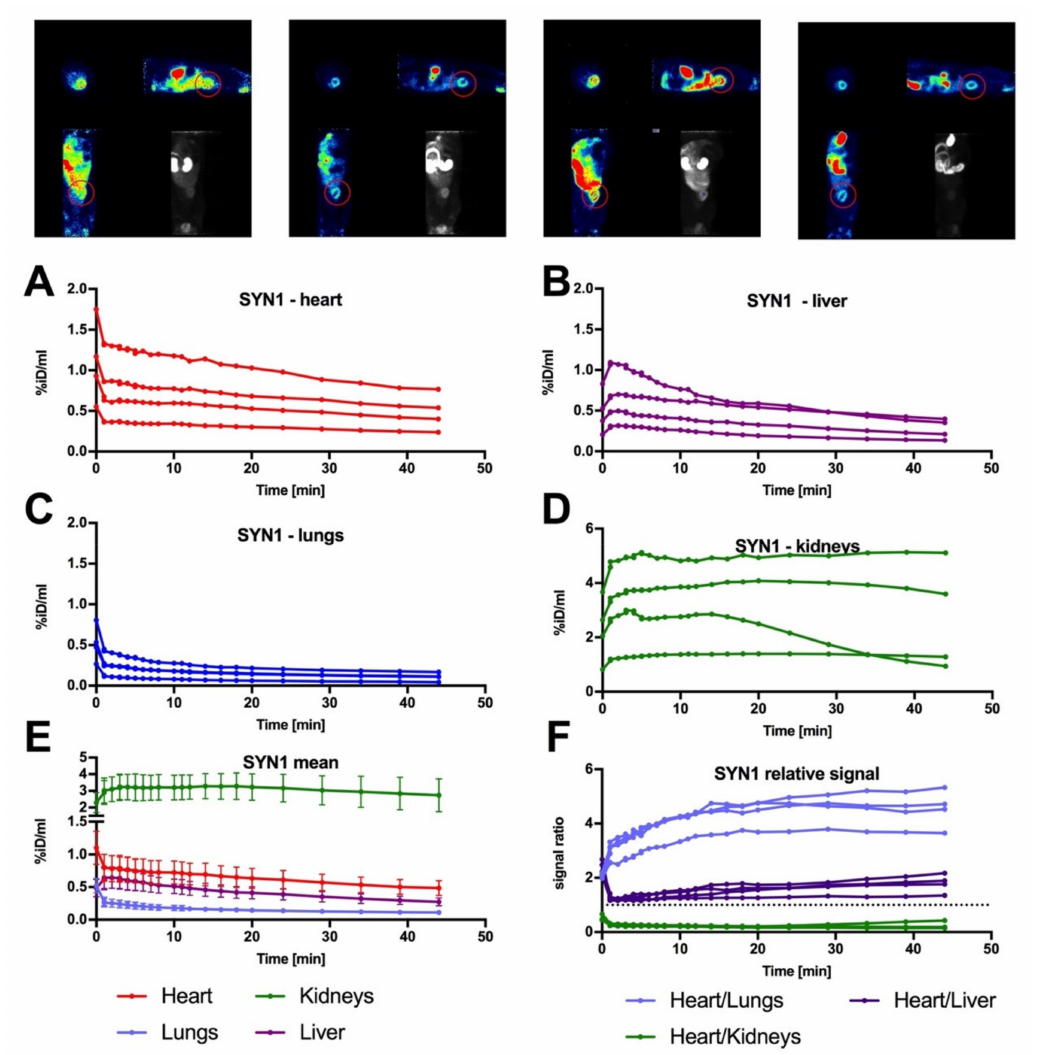
Figure 4. Biodistribution pattern of SYN1 in control rats. Above the graphs rats’ PET images of dynamic biodistribution of SYN1 are presented. Images represent all three planes at 20 min of color-coded images and a grayscale scan in the dorsal plane showing the average accumulation of the radiotracer in the body of each of the 4 animals. Red circles indicate exactly outlined myocardium on the lateral and dorsal planes. For analysis, signal was traced in 25 timepoints over 45 min for each of four animals (represented on the top of the figure) and collected for four different organs: heart, liver, lungs and kidneys ( A – D ). ( E ) Mean value with SEM for each organ. ( F ) Relative value of signal in the heart in relation to lungs, liver and kidneys. Dotted line represents 1:1